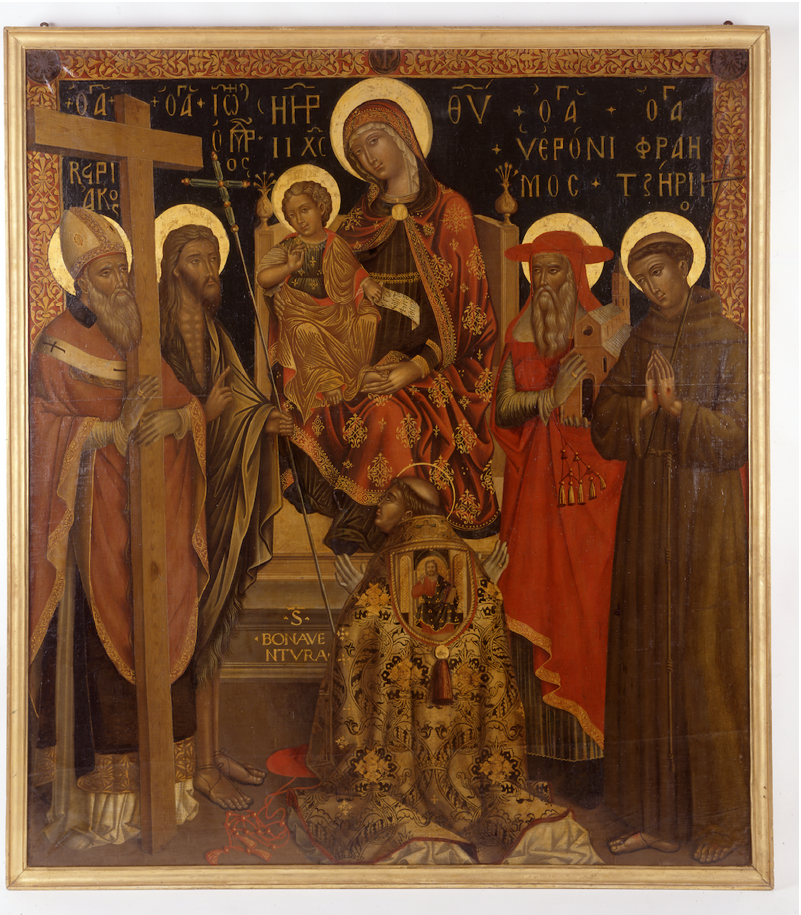
Figure 4. Madonna and Child with saints Cyriacus, John the Baptist, Jerome, Francis of Assisi, and Bonaventure, 1508. Vatican City, Apostolic Palace. © Musei Vaticani. Reproduced with permission.